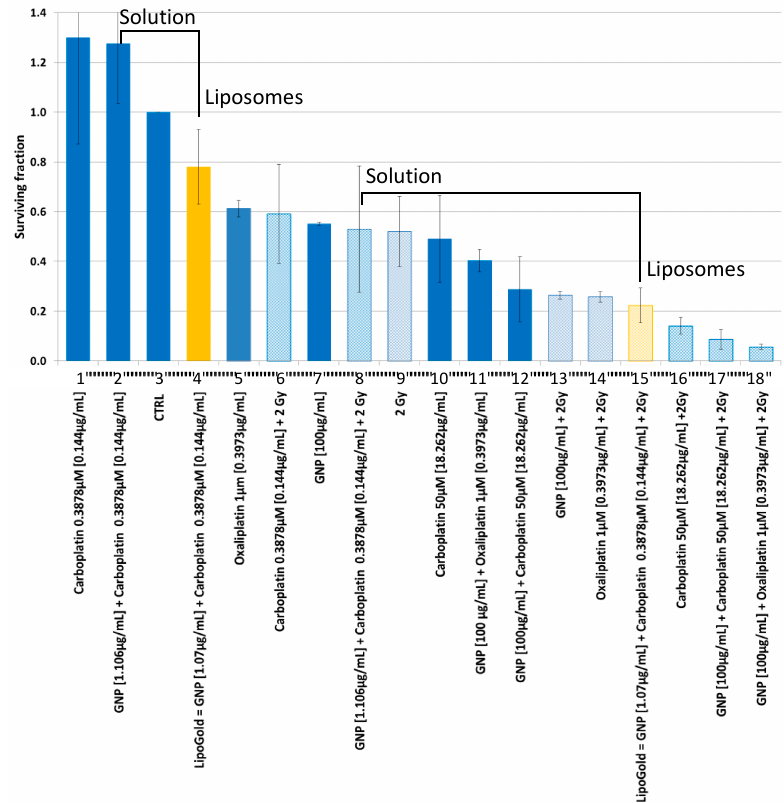
Figure 1. Clonogenic assay with a HCT116 colorectal cancer cell line. Survival fraction after different treatments combined or not with 2 Gy of X-ray radiation of ~80 keV. The measurements were repeated three times for each group. The efficiency of GNPs combined with carboplatin freely dissolved in solution or in liposomal formulation is highlighted.